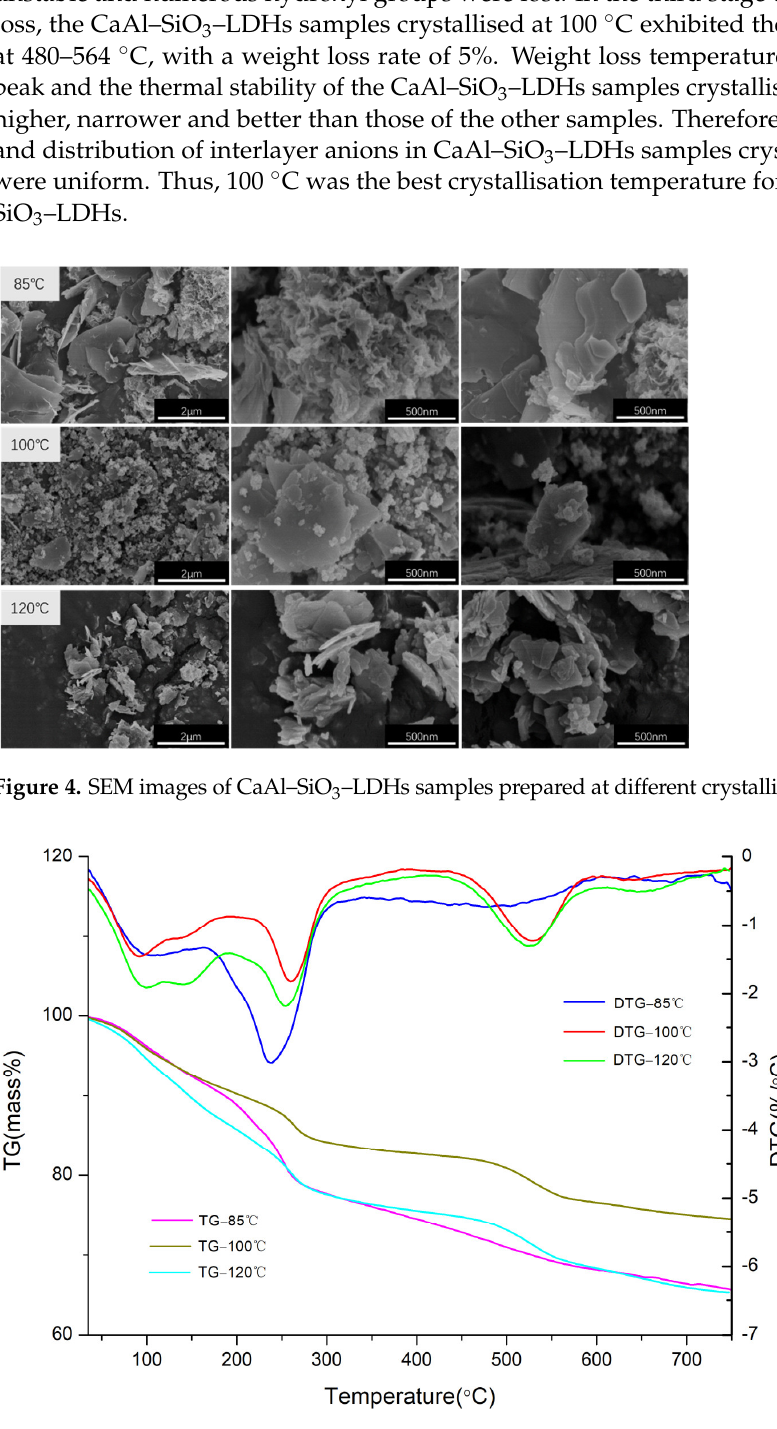
Figure 5. TG-DTG image of CaAl–SiO 3 –LDHs samples prepared at different crystallisation temperatures.